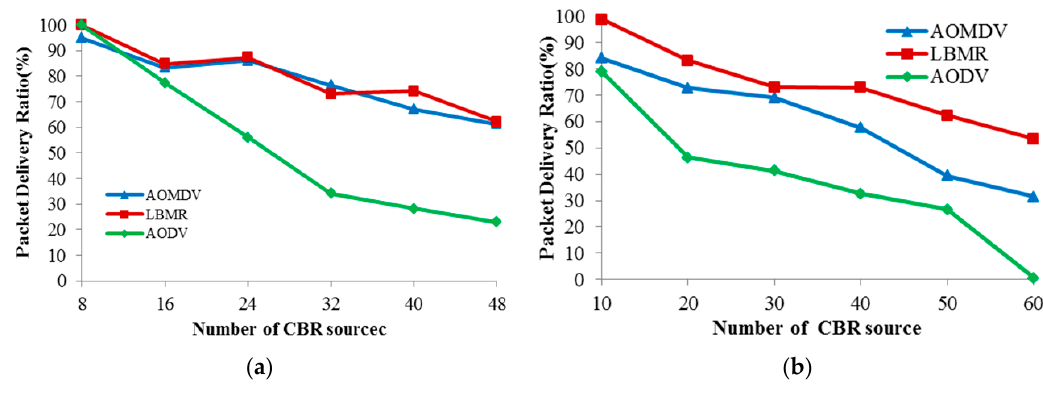
Figure 9. Packet delivery ratio. ( a ) Grid topology; ( b ) Random topology.